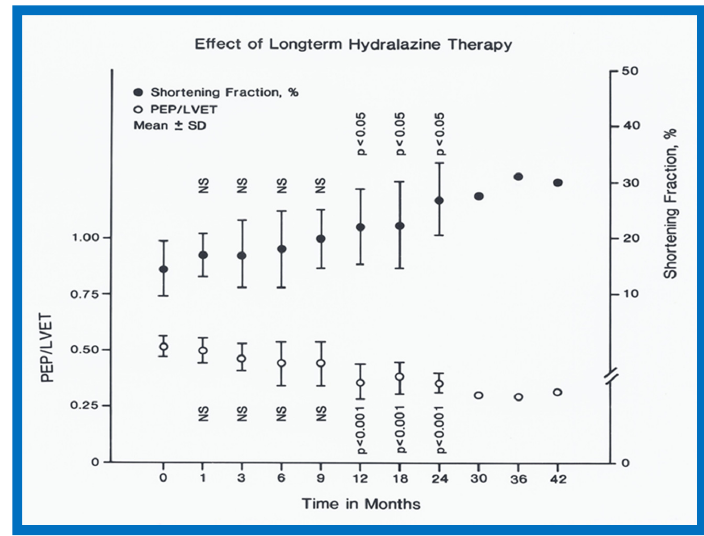
Figure 39. Pre-ejection period (PEP) / left ventricular ejection time (LVET) ratio (open circles) and shortening fraction in percent (%) (closed circles) are shown from prior to start of hydralazine therapy (0) and at 1, 3, 6, 9, 12, 18, 24, 30, 36 and 42 months following initiation of hydralazine therapy. Means and standard deviations (SD) are shown. The number of subjects at 30, 36 and 42 months is small and therefore, only mean values are shown. Note the gradual improvement in PEP / LVET and shortening fraction. Statistically significant ( p < 0.05 to < 0.001) change becomes apparent from 12 months follow-up onwards. Reproduced from Rao P.S., Andaya W.G. [12].